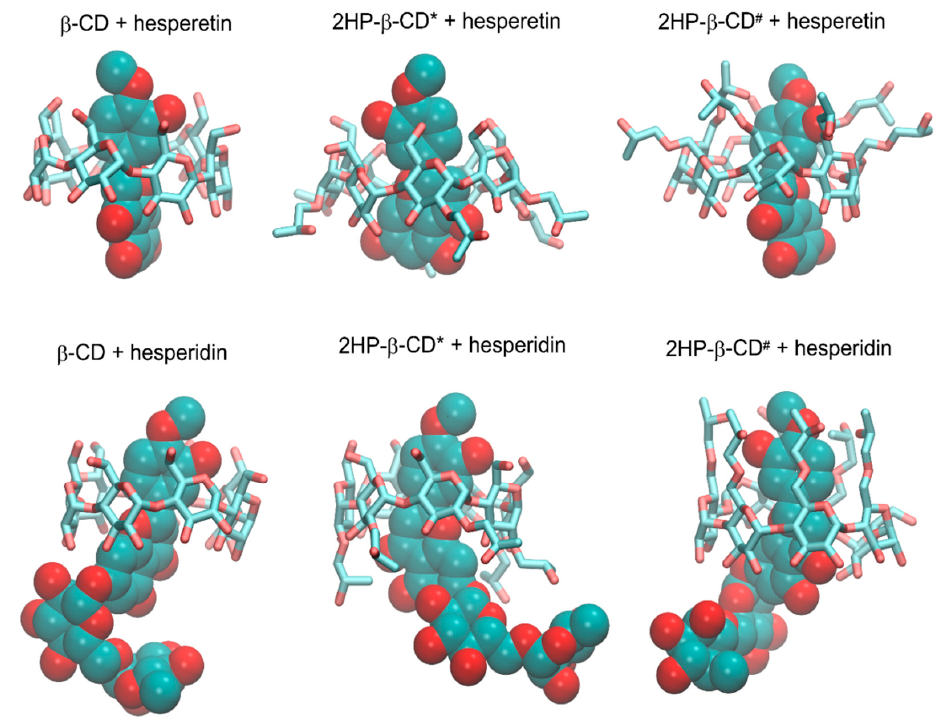
Figure 10. The exemplary structures of the guest–host complexes, generated during MD simulations. The two alternative substitution patterns of β -CD by the 2HP groups were considered. Hydrogen atoms are not shown. 2HP- β -CD* denotes that all 2HP groups are substituted to the O(2) hydroxyl oxygen atoms of β -CD; 2HP- β -CD# denotes that all 2HP groups are substituted to the O(6) hydroxyl oxygen atoms of the hydroxymethyl groups present in β -CD.